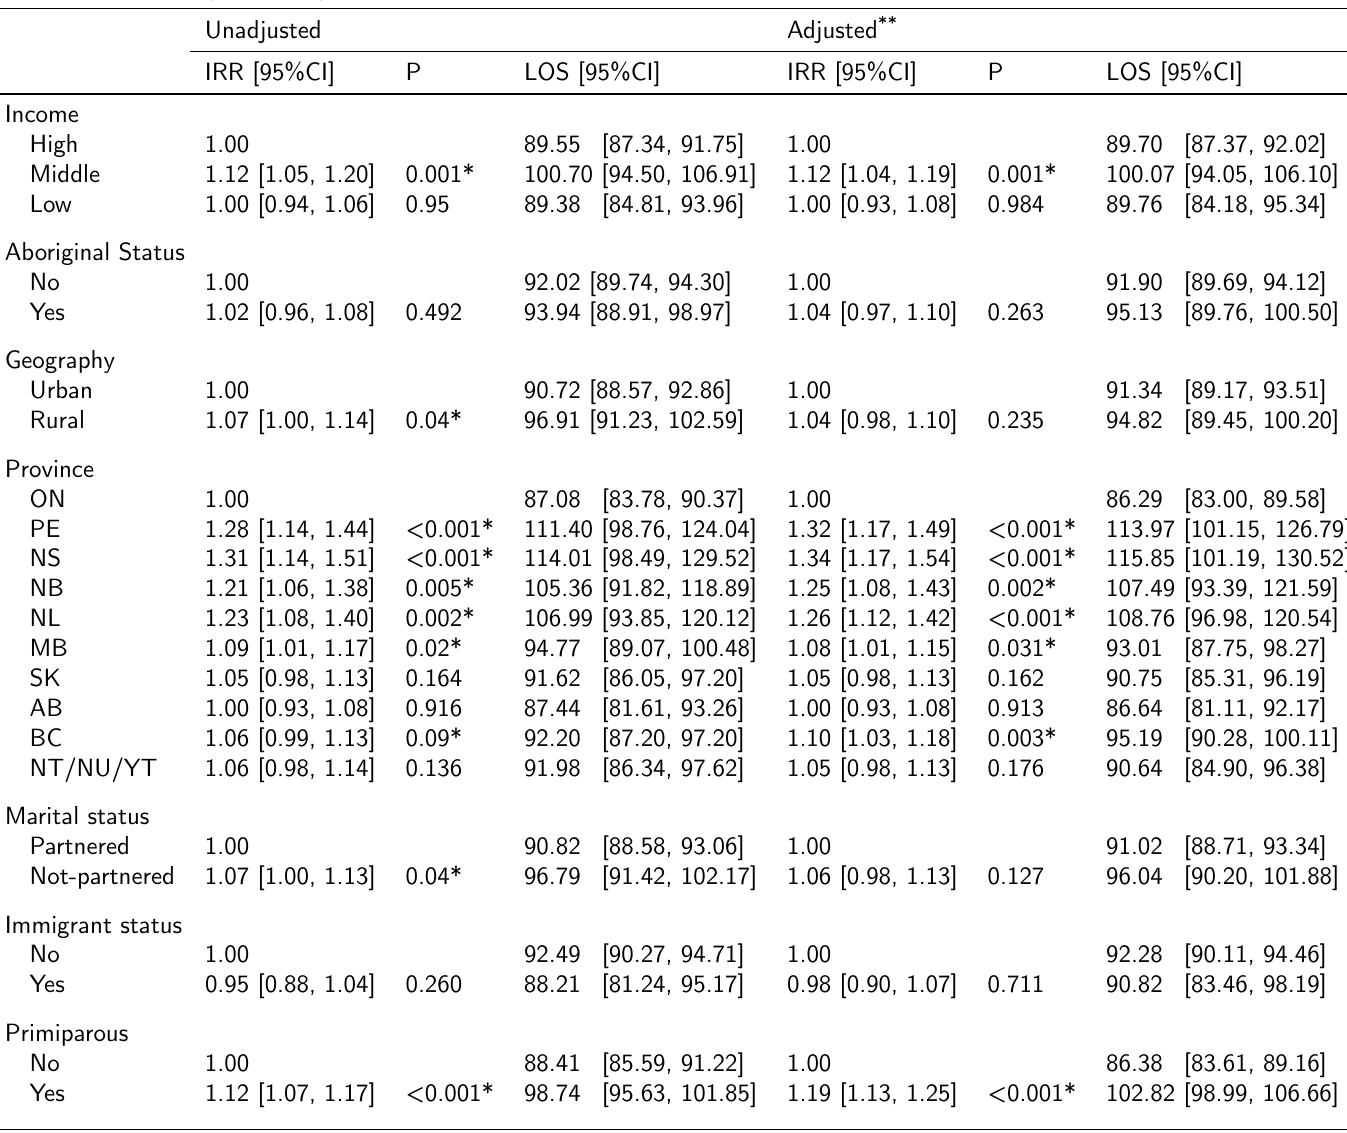
Supplementary Table 4, cont. Incidence rate ratios and marginal estimates of length of stay (LOS) in hours Caesarian Delivery (n = 6,012)